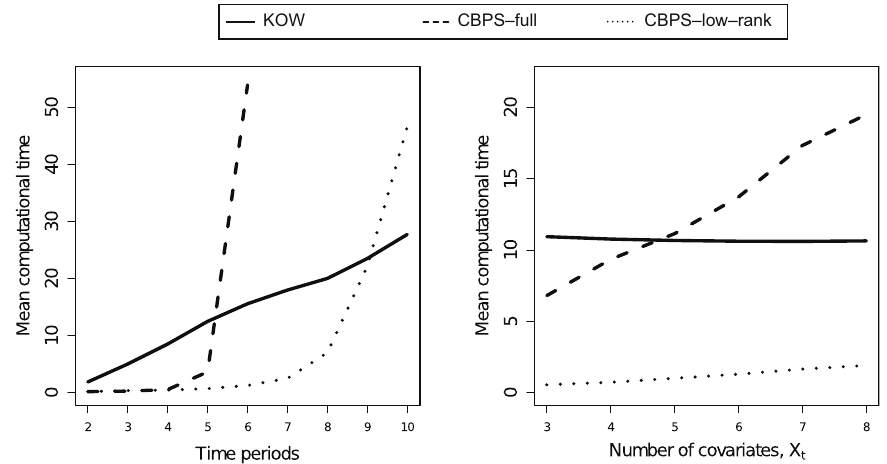
Figure 6: Mean computational time in seconds of KOW ( solid ) , CBPS with full covariate matrix ( dashed ) , and CBPS with the low - rank approximation of the full matrix ( dotted ) over time periods when n 100 = , p 3 = and T 2,…, 10 = ( left panel ) and over number of covariates, when n 100 = , T 5 = and p 3,…, 8 = ( right panel )